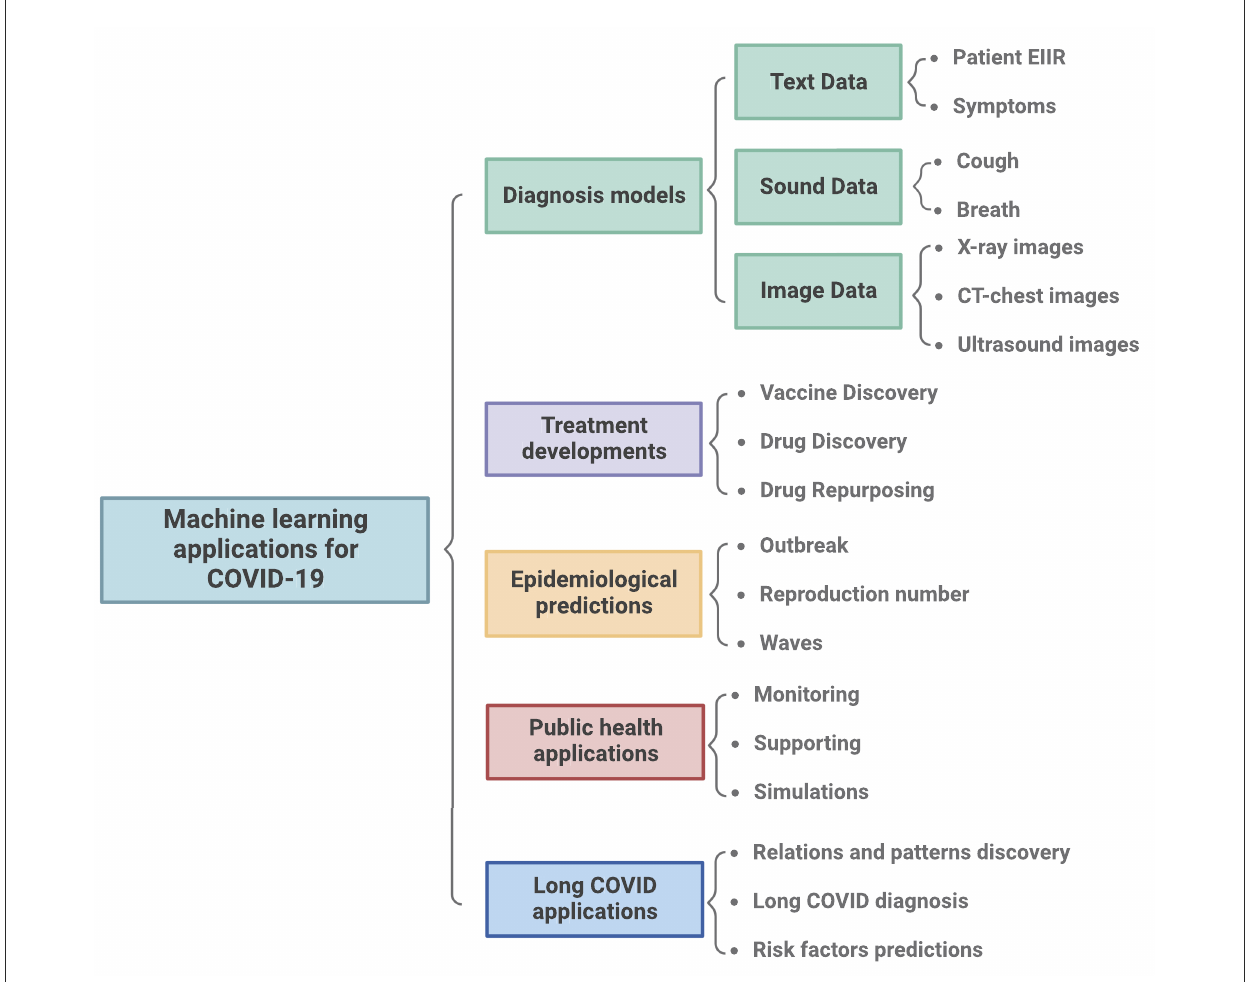
FIGURE3 Summary of machine learning applications to fight COVID-19 during the pandemic. General applications of machine learning were classified into 5 categories: i) The design of diagnosis models based on different types of inputs like CT chest, X-ray images, and symptom descriptions. ii) Treatment development. iii) The development of epidemiological models to predict new waves and outbreaks. iv) The simulation of potential scenarios, and monitoring systems to guide public health decisions. v) The diagnosis and identification of risk factors in long